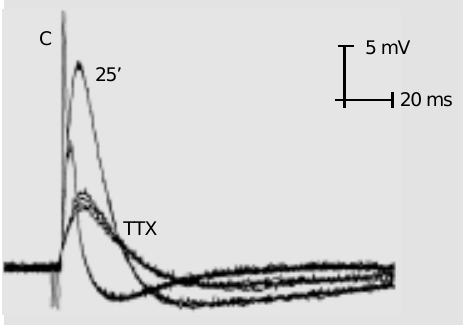
Figure 5. Effect of 1 µM tetrodo- toxin (TTX) on action potential in a Bcg-3 (100 µg/ml)-pretreated nerve. C = control conditions (before TTX); 25' = 25 min after Bcg-3 application and washout of the preparation (and after